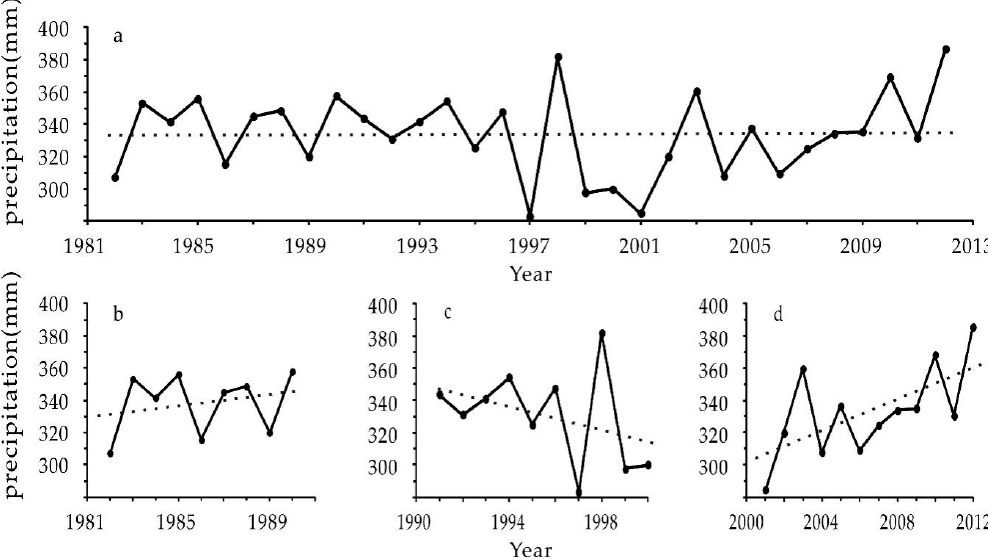
Figure 2. Precipitation Change Trend of Northern China ( a . 1982–2012; b . 1982–1990; c . 1991–2000; d . 2001–2012).